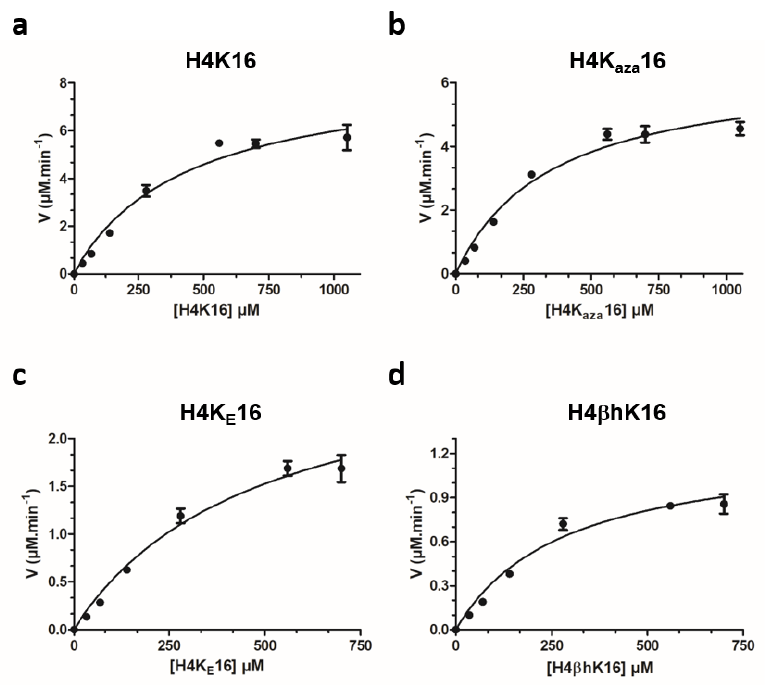
Figure 4. Michaelis–Menten plots of the KAT8-catalysed acetylation of: ( a ) H4K16; ( b ) H4K aza 16; ( c ) H4K E 16, and ( d ) H4 β hK16. Table 1. Kinetics parameters for the KAT8-catalysed acetylation of H4K*16 histone peptides. H4 Peptide